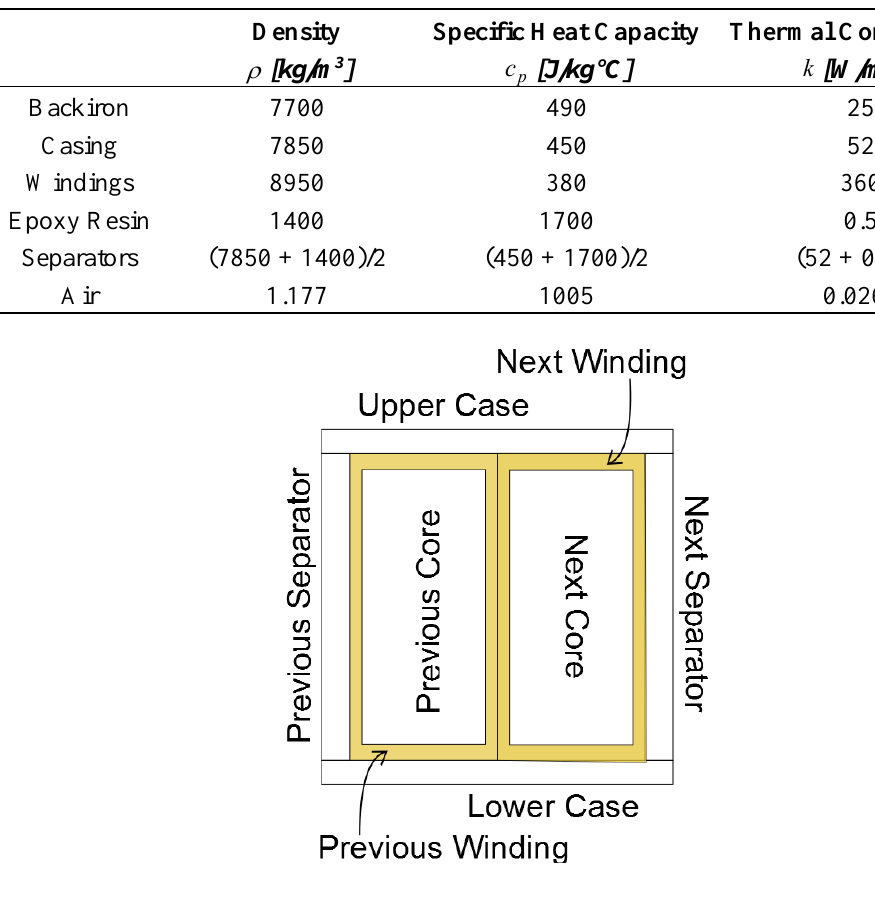
Figure 11. Geometry of th AFSRM used for the transient thermal